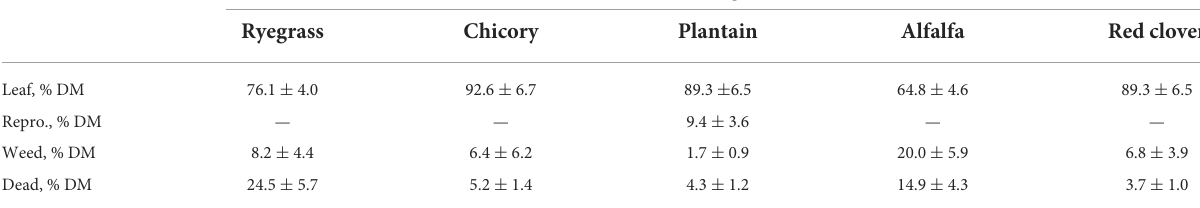
TABLE 3 Botanical composition of the herbage composing the single forage perennial ryegrass diet ( Lolium perenne L. ; RYE) or a taxonomically diverse multi-forage choice (DIV) diet of ryegrass, chicory ( Cichorium intybus L.), alfalfa ( Medicago sativa L.), plantain ( Plantago lanceolata L.), and red clover ( Trifolium pretense L.). Values for ryegrass botanical information were not different by treatment so herbage averages are presented ( P >